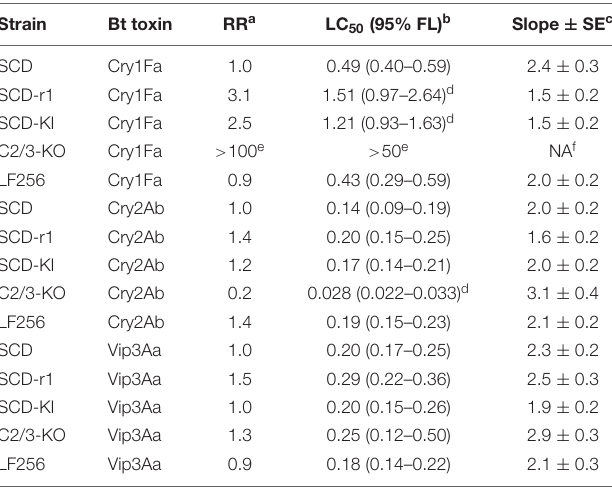
TABLE 3 | Responses to Cry1Fa, Cry2Ab, and Vip3Aa by larvae from the susceptible SCD strain and four Cry1Ac-resistant strains of H. armigera